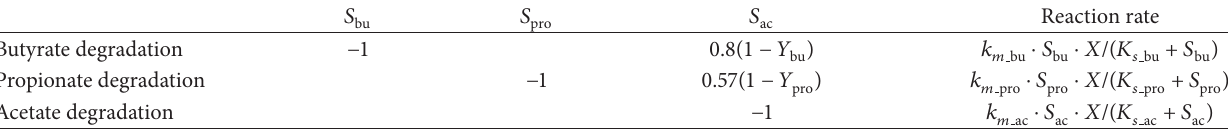
Table 1: Biokinetic applied in the integrated model [26].